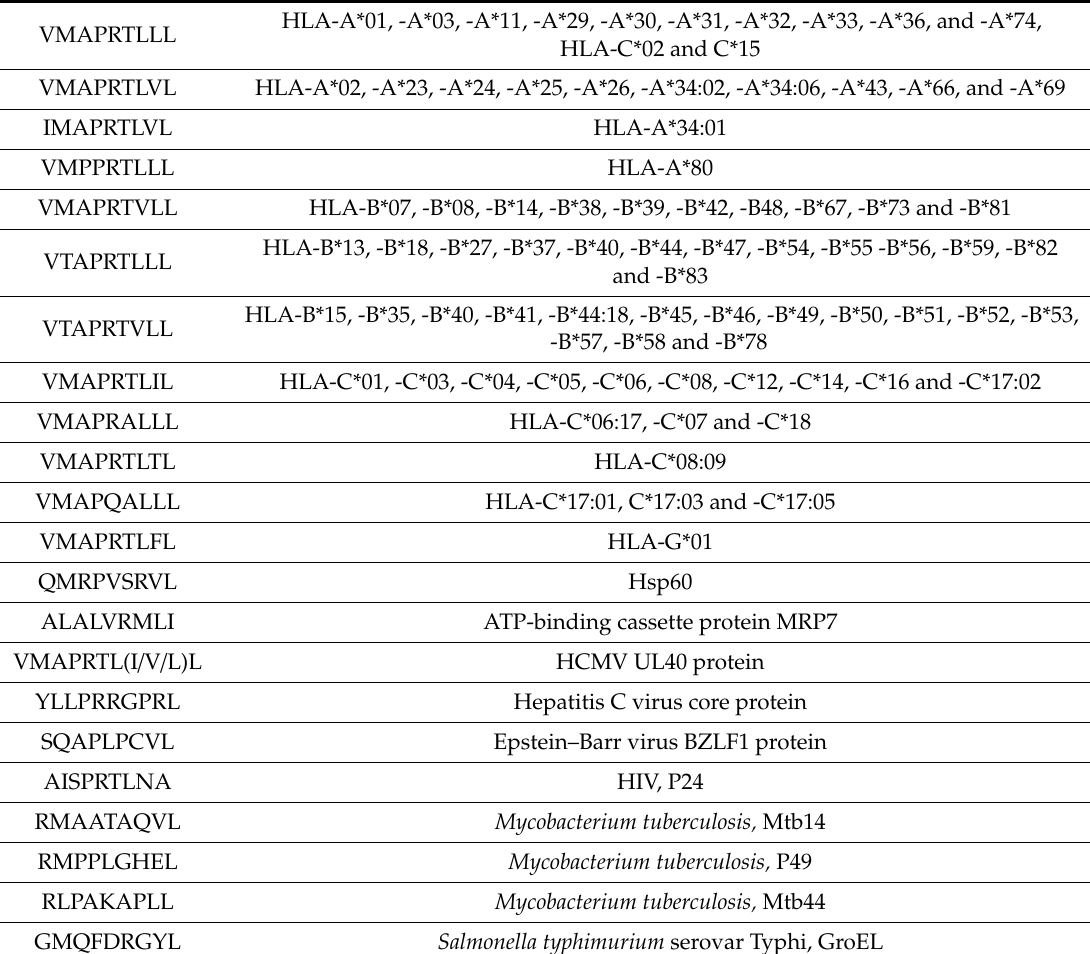
Table 1. Peptides, derived from leader sequences of HLA class I proteins, endogenous proteins Hsp60 and MRP7, and pathogen-derived peptides, presented by HLA-E. From Lauterbach et al. [11], and Sharpe et al. [12], with